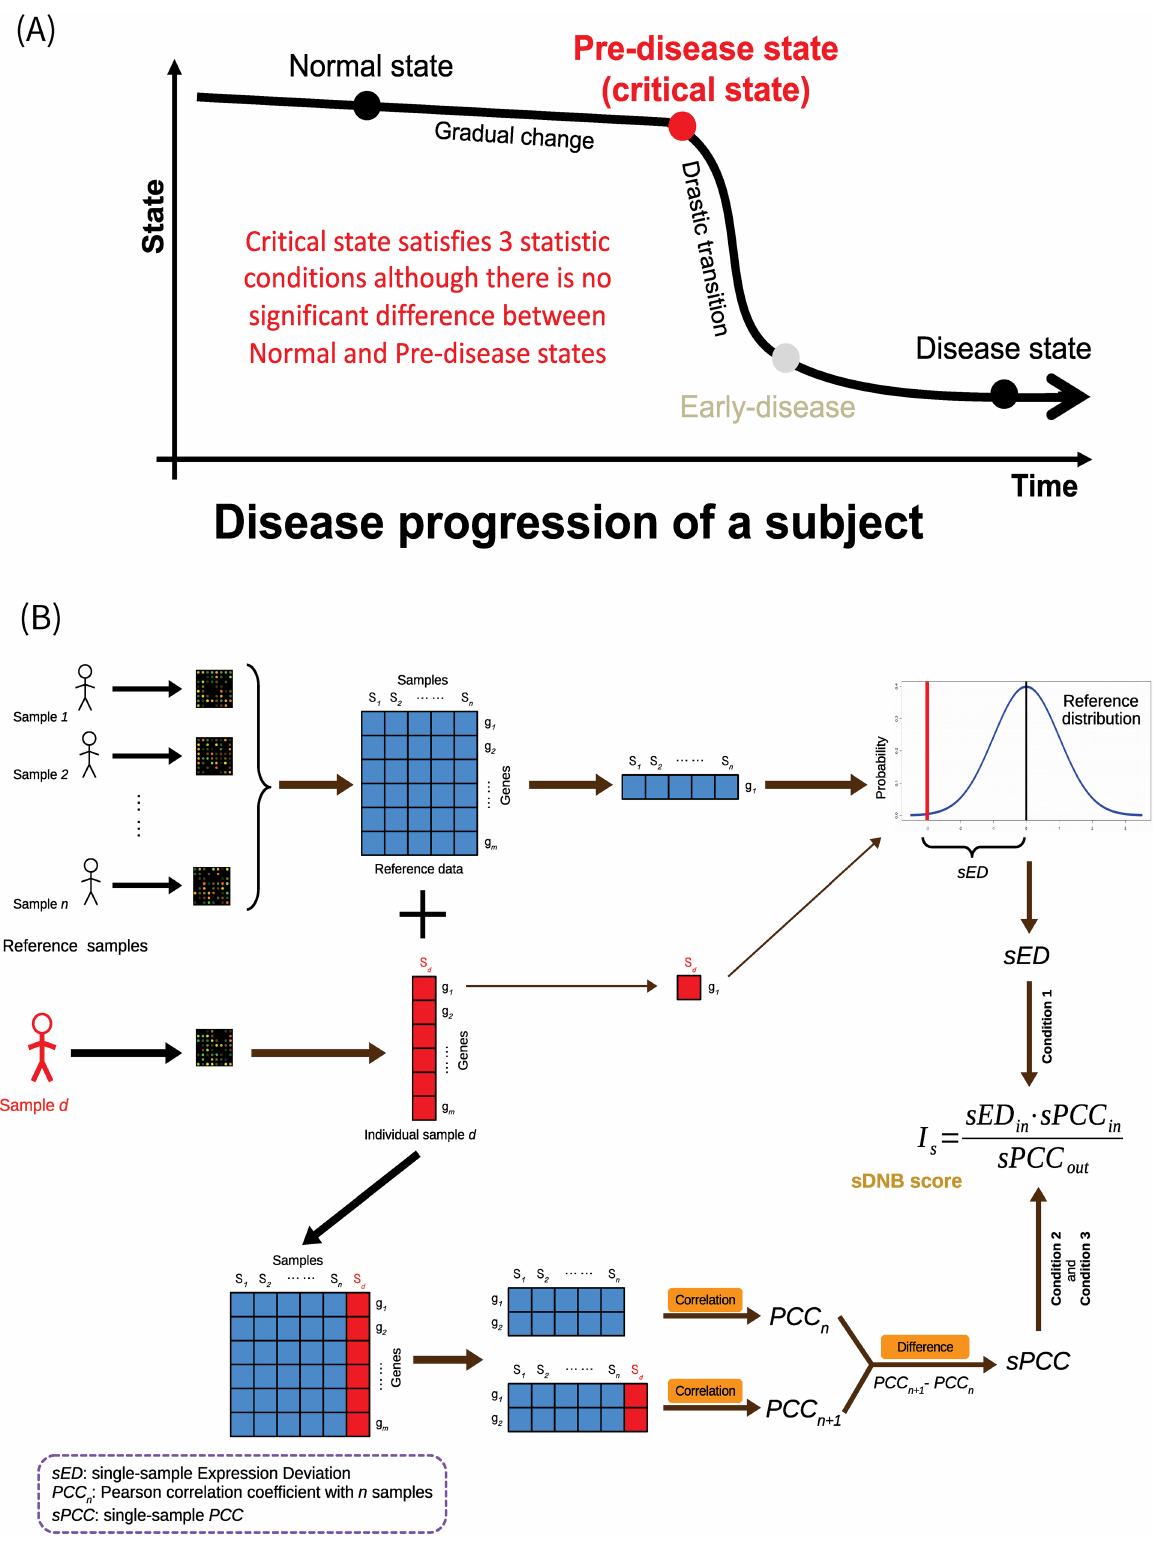
Fig 1. Diseaseprogression and dynamic network biomarkers. (A) Three states duringa diseaseprogression. Clearly, there are significantdifferences betweennormal and diseasestates in terms of molecularexpressions, and that is why traditionalbiomarkers can